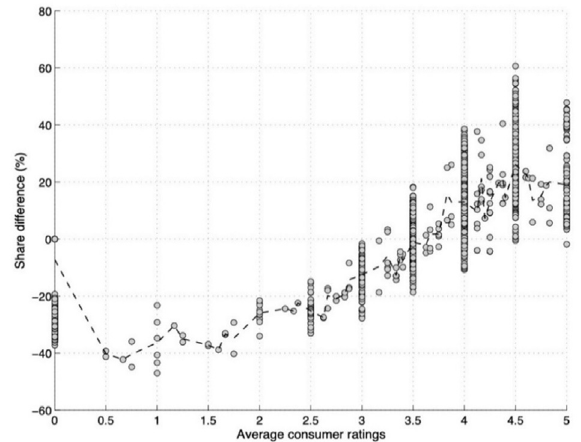
Fig. 5. 2D scatter plot of percentage market share differences with and without consumer reviews across products and time.